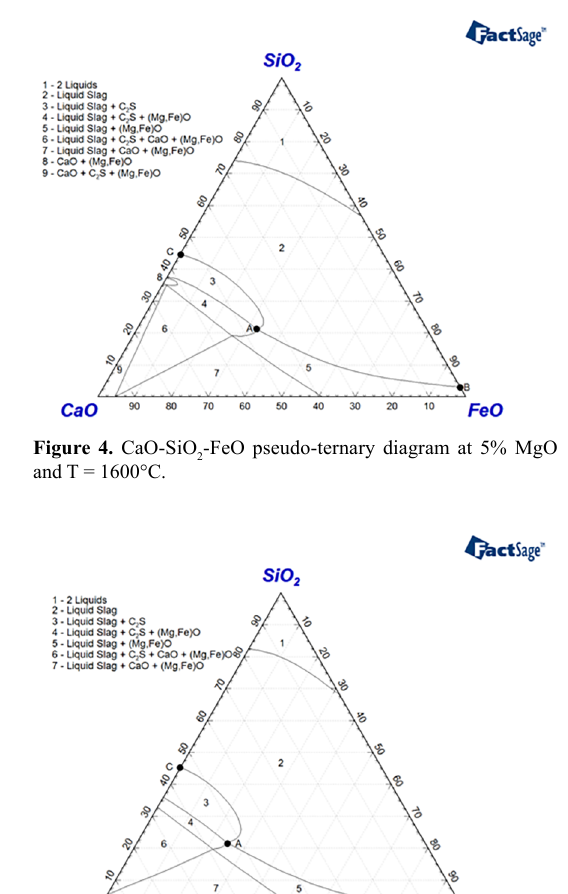
Figure 5. CaO-SiO 5% MgO, T =